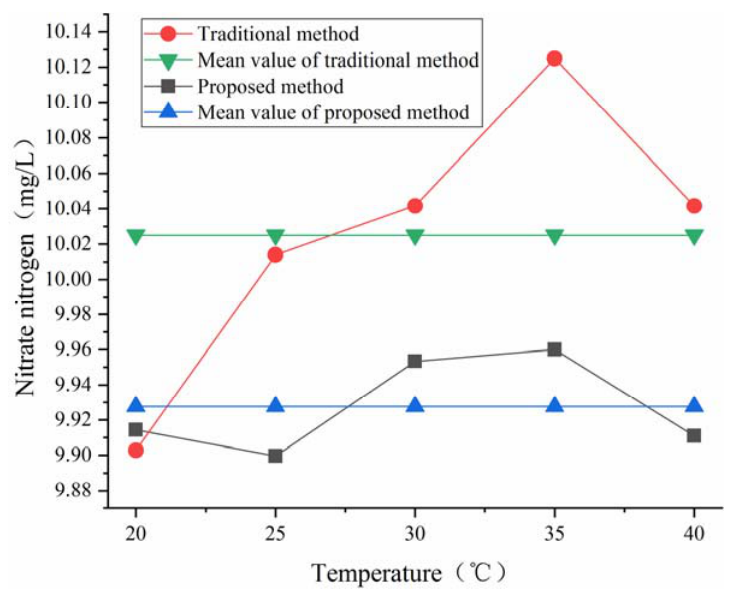
Figure 11. Environmental adaptability test at different temperatures.